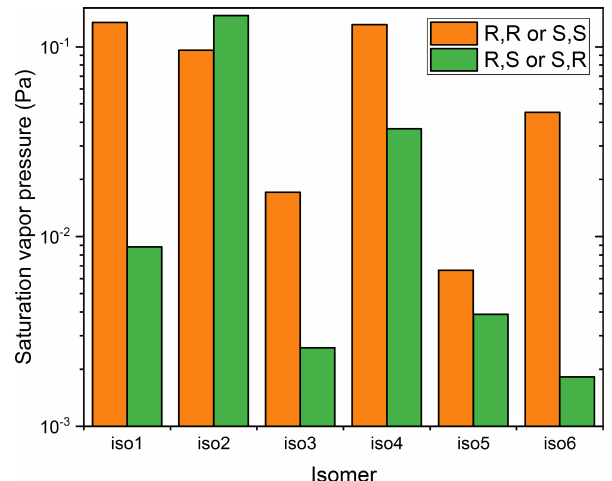
Figure 3. Saturation vapor pressures, at 298.15K, of dif- ferent isomers of the dihydroxy dihydroperoxide C 5 H 12 O 6 , at 298.15K, calculated using COSMOtherm version 18 and the BP_TZVPD_FINE_18 parameterization (based on BP/def2- TZVPD//BP/def-TZVP quantum chemical data), with the System- atic conformational sampling scheme.